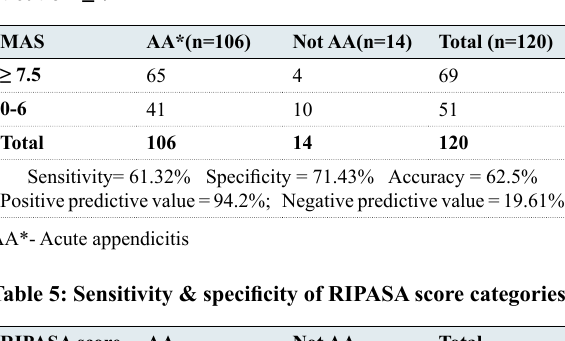
Figure 1: Frequency of type of acute appendicitis (n=106) Among those with a MAS ≥7, 65 out of 69 (94.2%) had acute appendicitis while 66.67% (10 out of 15) with score ≤ 4 had appendicitis. At a cut off value of ≥7, MAS had a sensitivity of 61.32%, a specificity of 71.43% and an accuracy of 62.5 percent (Table 4). Table 4: Sensitivity & specificity of Modified Alvarado score